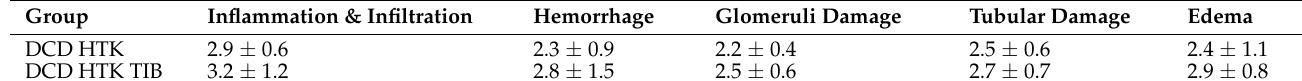
Table 1. Histological Evaluation of HE stained kidney sections, n = 7.